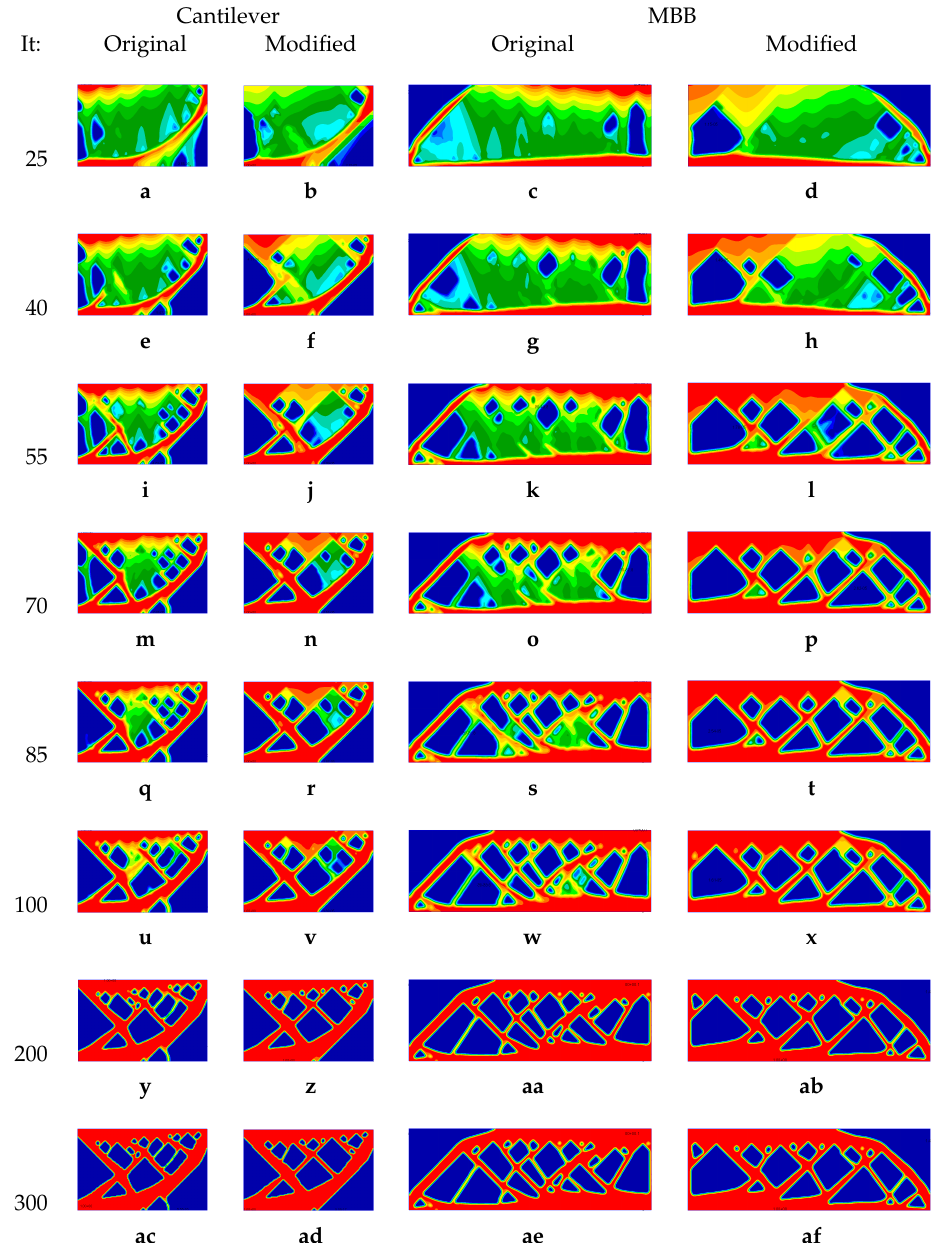
Figure 7. Comparison of the topology optimization problem of MBB using the original and modified version of the fabrication